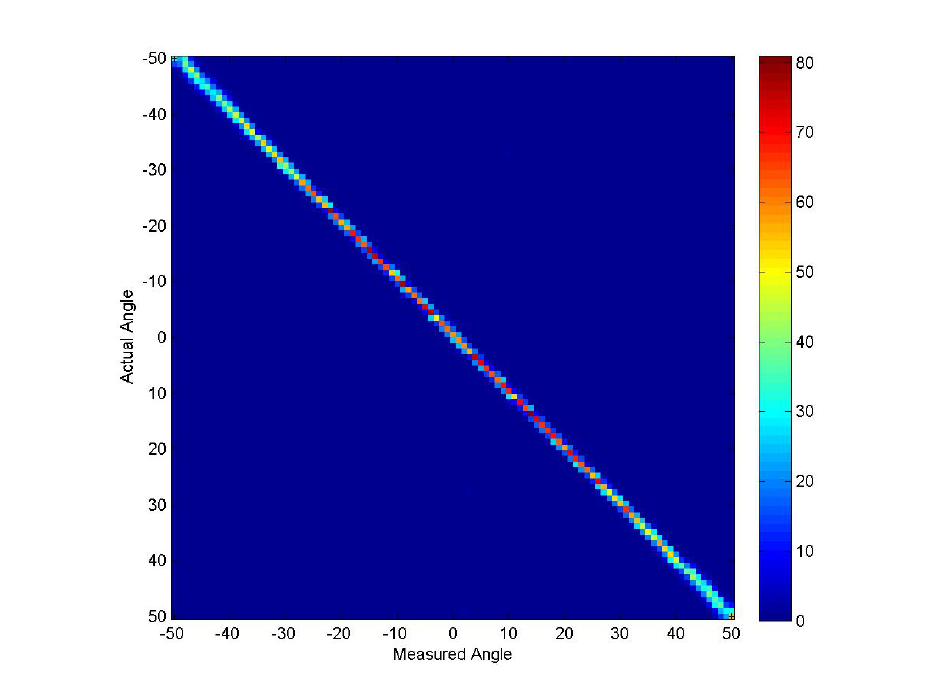
Figure 13. Ambiguity plot for Experiment 4 (13-dB threshold).